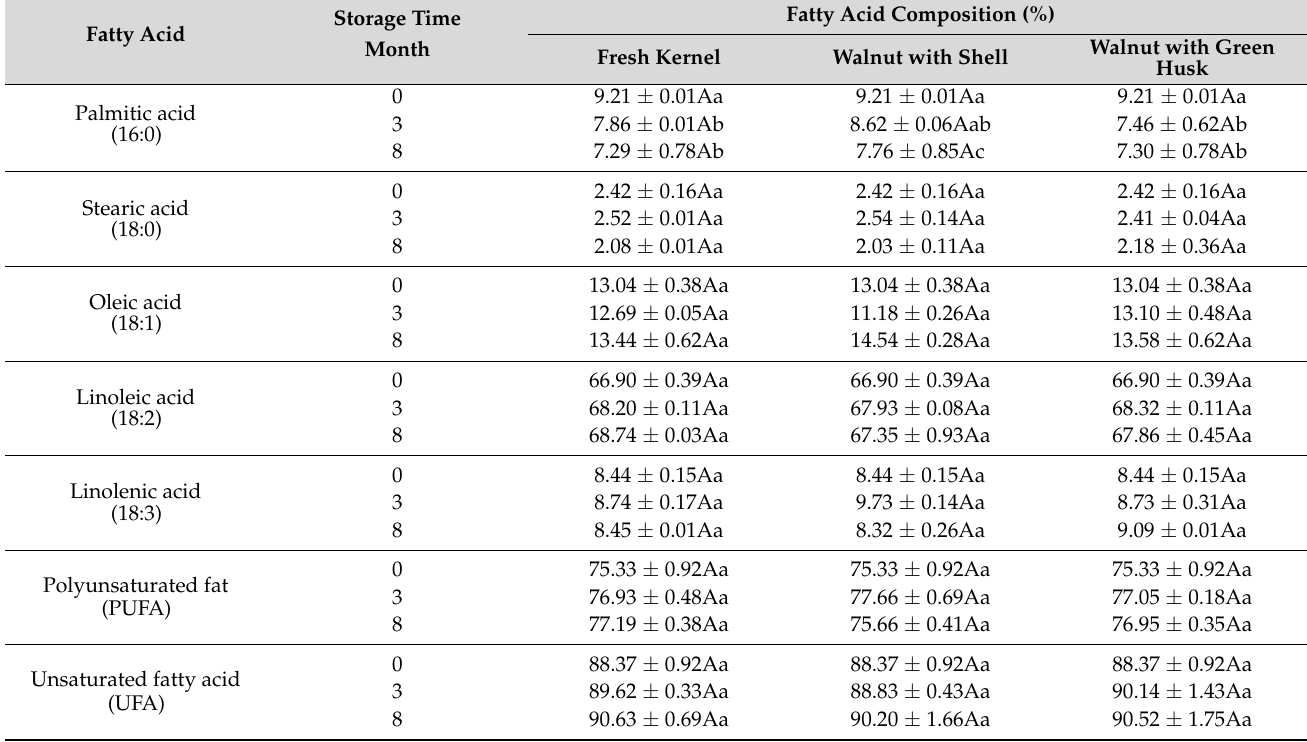
Table 2. Fatty acid changes of walnut kernels during the storage of − 20 ◦ C. Note: Values with different lowercase letters in the same column ‘a–c’ and uppercase letter ‘A–B’ in the same row are significantly different ( p < 0.05) from each other during